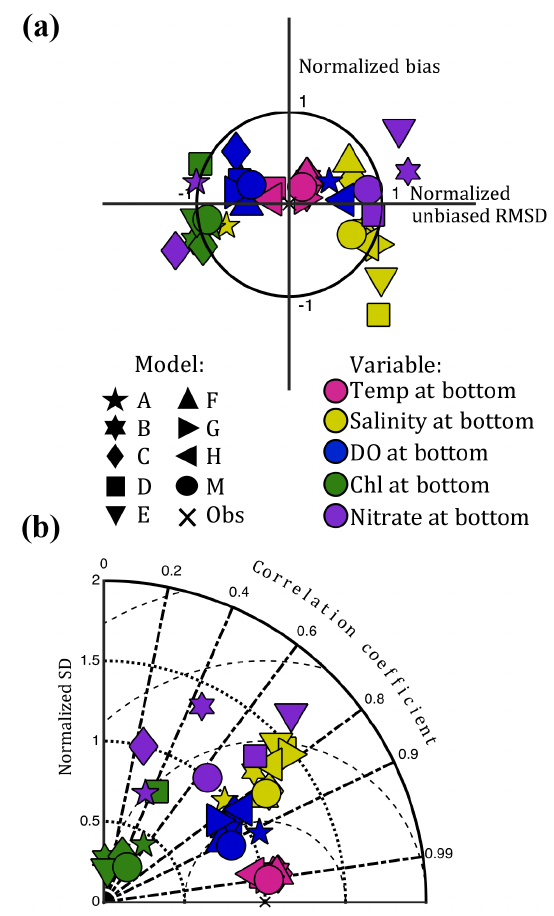
Figure 8. Normalized summary (a) target and (b) Taylor diagram illustrating model skill of bottom temperature, salinity, chlorophyll, nitrate, and dissolved oxygen at 13 Chesapeake Bay stations for 2004–2005. The “x” represents the skill of a model that perfectly reproduces the